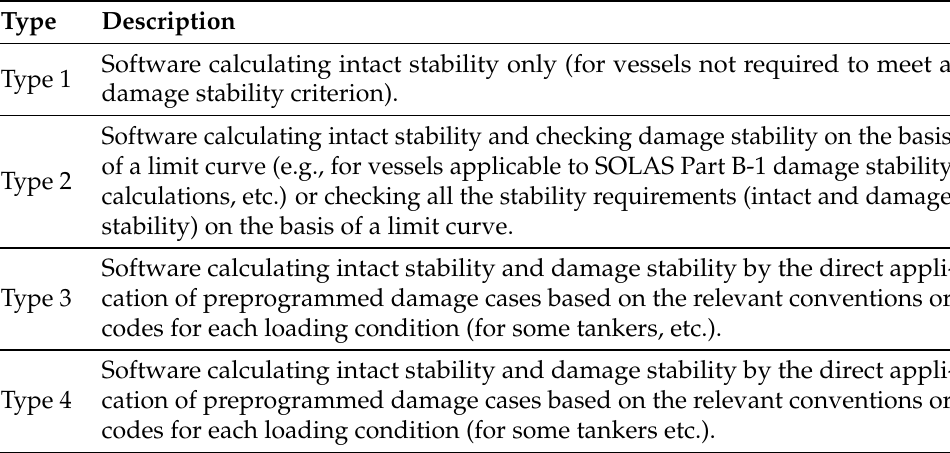
Table 1. Four types of loading